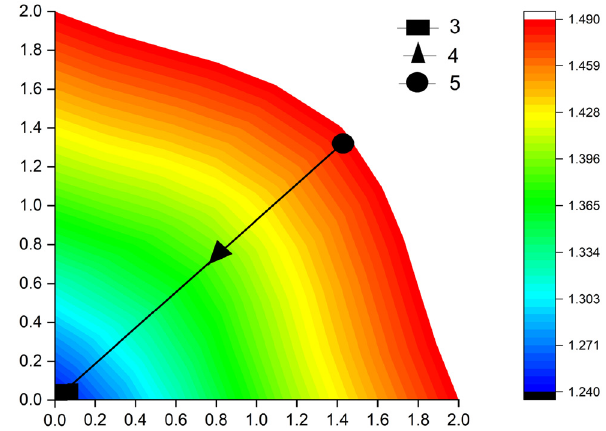
Figure 4: Microscopic ATR - FTI image of the methylene of MTC phe - nolic fi